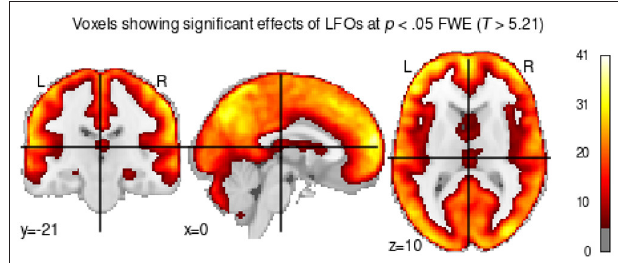
FIGURE 5 | T -test showing voxels whose brain activity was significantly captured by the oscillatory regressors.